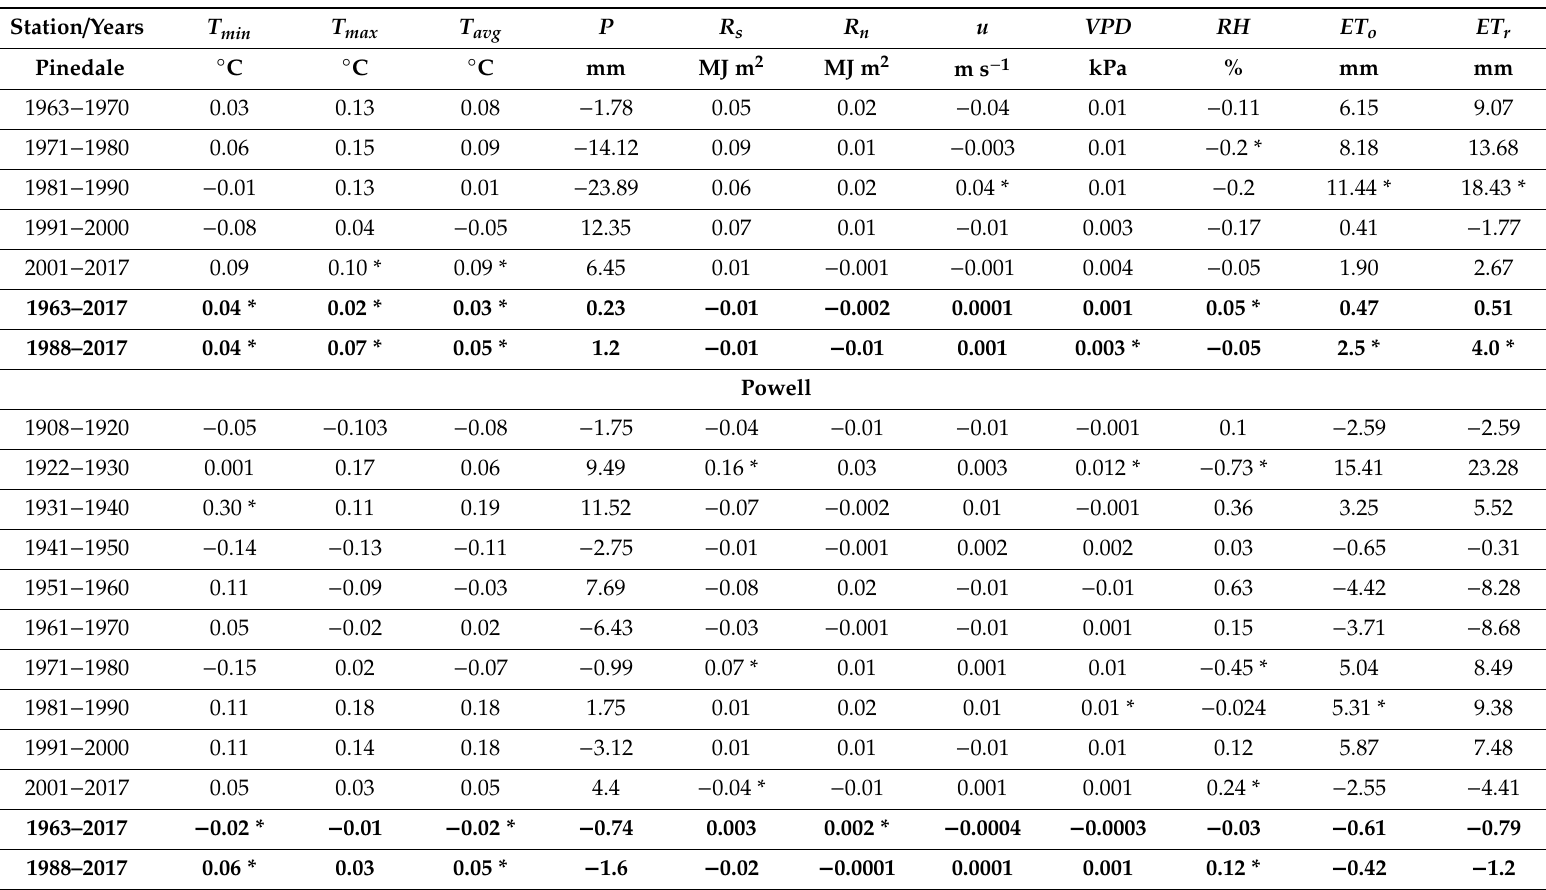
Table 4. Magnitude of change (unit per 10-year, 1963–2017, and 1988–2017 period,) statistics (Theil-Sen Slope, Qi) of the meteorological variables at four weather stations in the state of